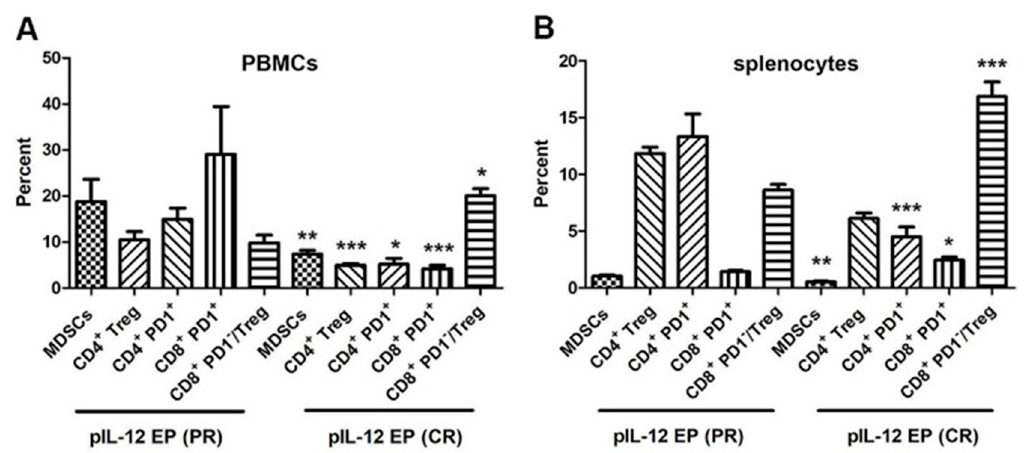
Figure 7. pIL-12 GET induced prevention against rechallenge via down regulation of immune suppressor cells and exhausted cells. Peripheral blood mononuclear cells (PBMCs) ( A ) and splenocytes ( B ) were harvested at 20–30 days post rechallenge with 5 × 10 5 B16F10 cells from PR and CR mice for flow cytometry assay. Pooled data from two independent experiments are shown as mean +/ − SEM (animals in each group, n = 6–10). Independent T -test, p * < 0.05, p ** < 0.01, p ***< 0.001.